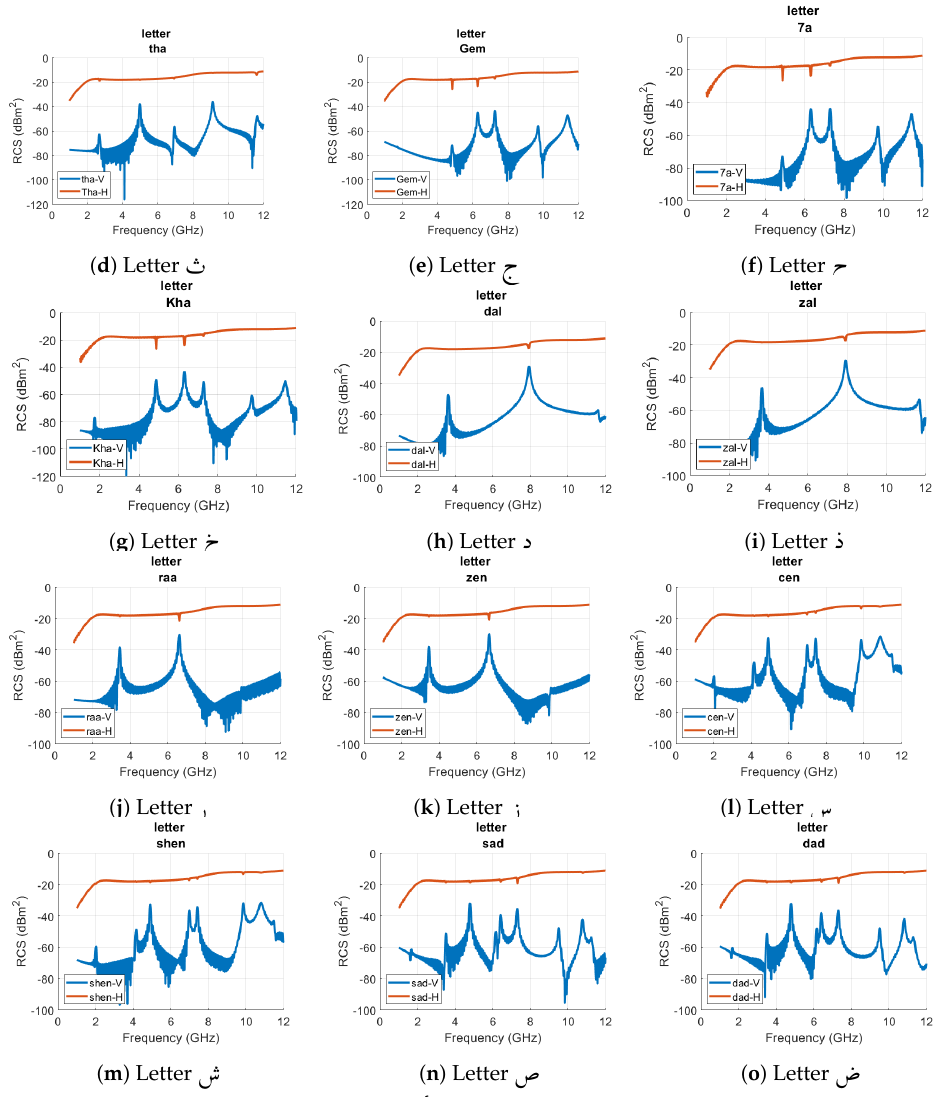
(cid:9) X , P , (cid:9)P , (cid:128) , (cid:17) (cid:128) , (cid:144) , (cid:9) (cid:144) ) with Arial (cid:9) (cid:9) (cid:9) (cid:9) (cid:88) , (cid:80) , (cid:9)(cid:80) , (cid:128) , (cid:17) (cid:128) , (cid:144) , (cid:144) ) with Arial X , P , (cid:9)P , (cid:128) , (cid:17) (cid:128) , (cid:144) , (cid:144) ) with Arial